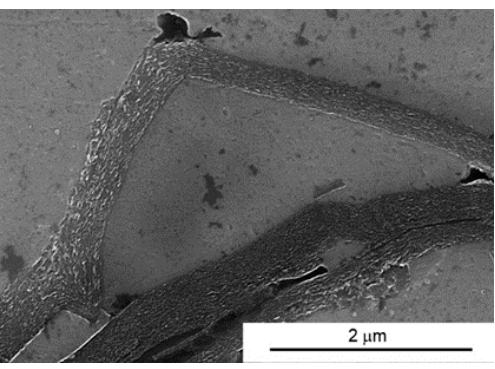
Figure 7. Microstructure of AA6061/10 vol % MLG composite obtain in SPT process.